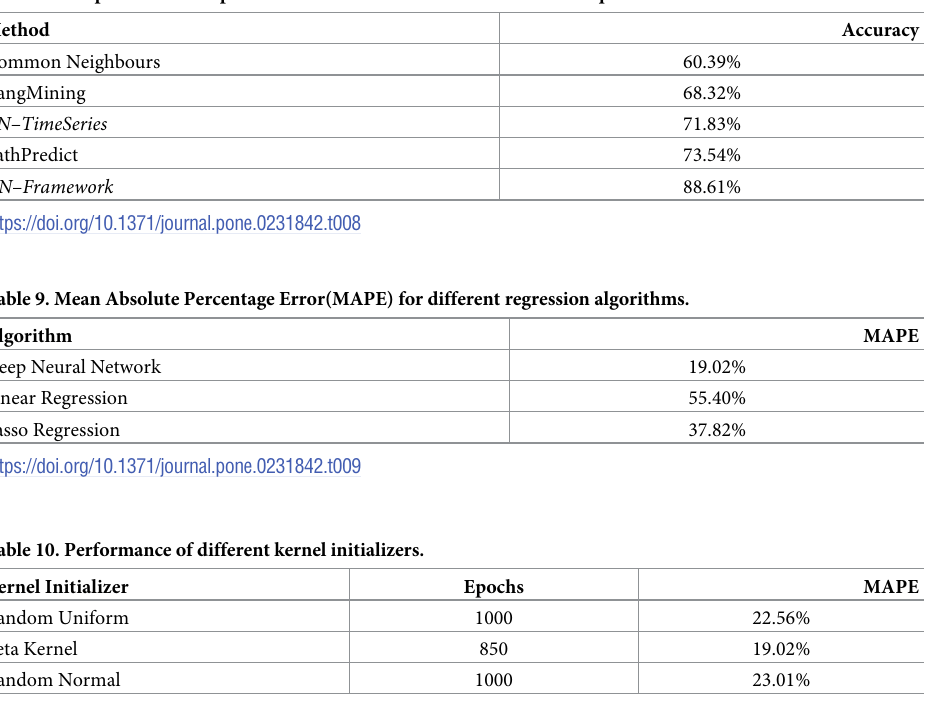
Table 8. Comparison of link prediction results with state-of-the-art techniques.